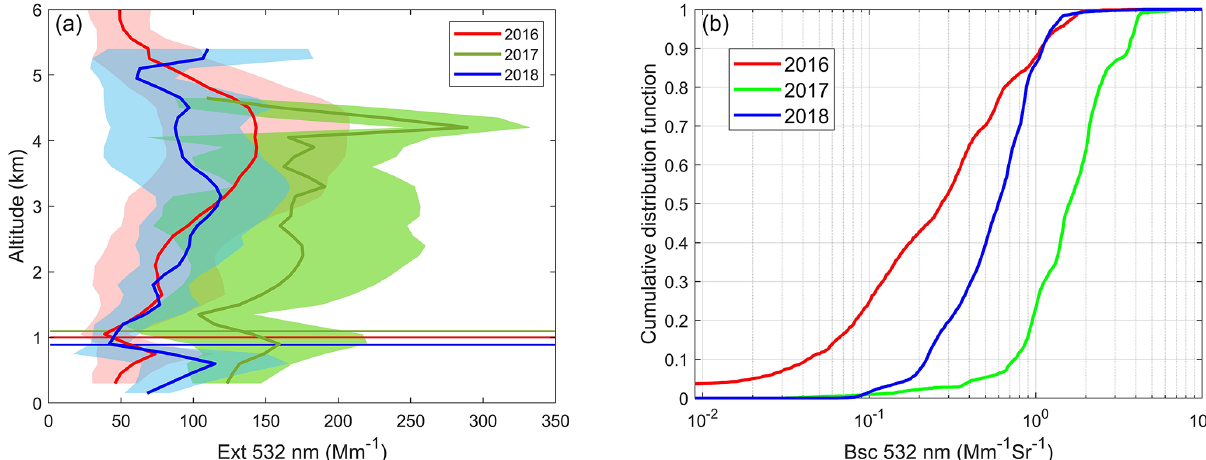
Figure 13. (a) A composite of vertical profiles of aerosol extinction at 532nm, derived from HSRL-2 measurements for each of the de- ployment months bounded by 5–15 ◦ S and 2.5–7.5 ◦ E. Shaded regions represent 1 standard deviation of extinction measurements. Solid horizontal lines indicate the mean cloud top heights for each dataset. (b) Cumulative distribution function for mean aerosol backscattering in the 300m layer above cloud